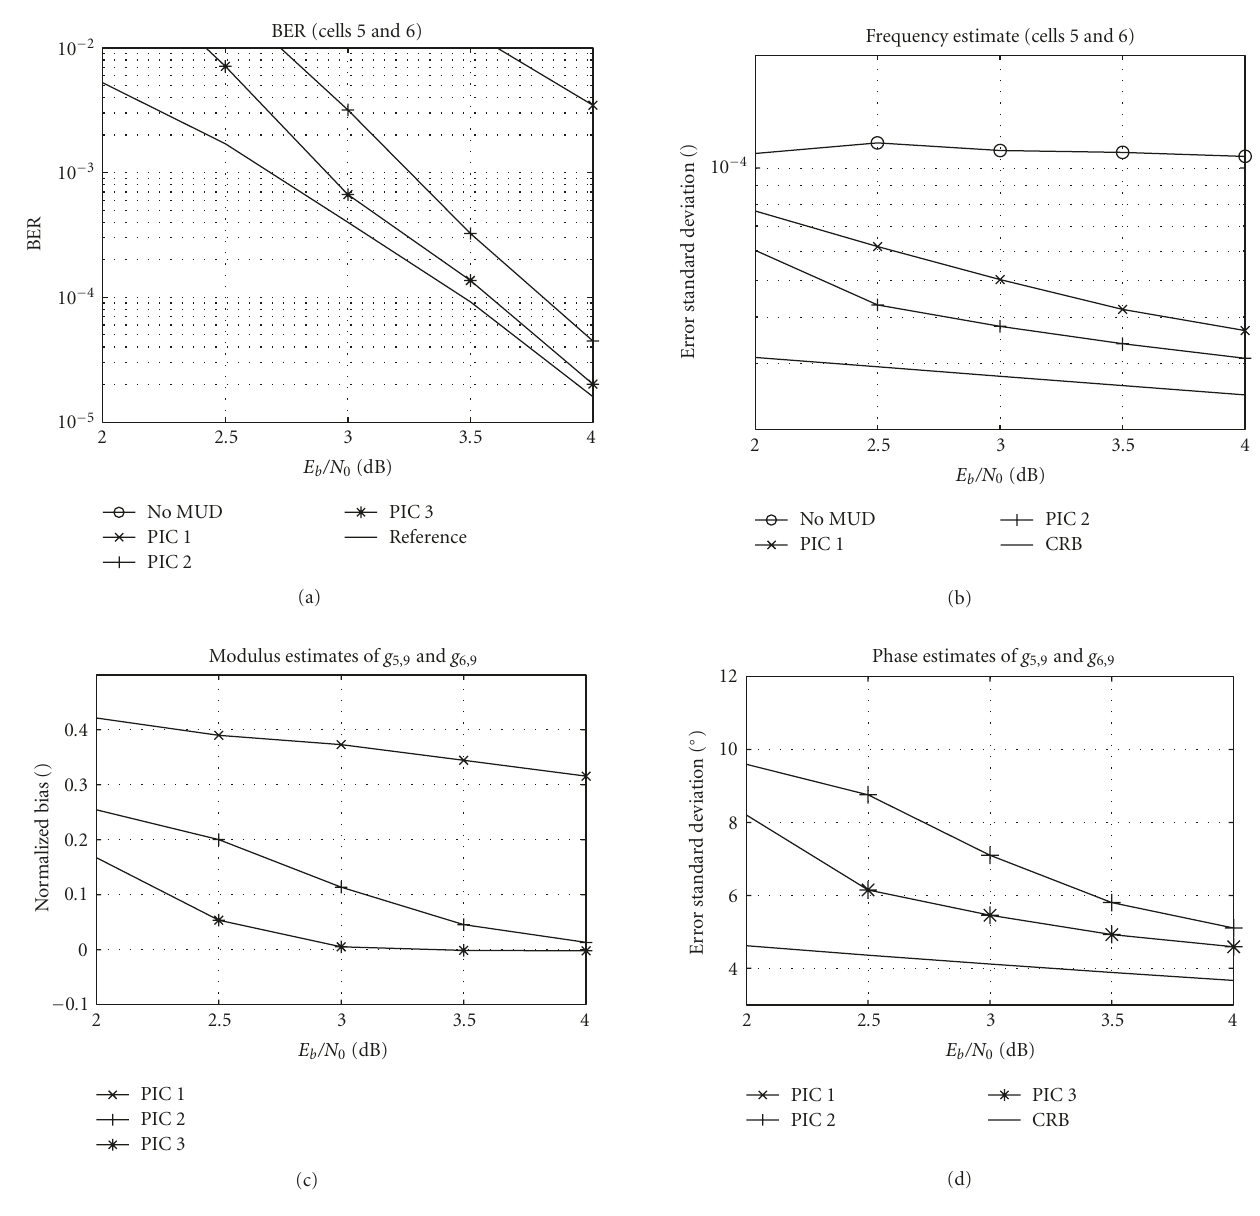
Figure 10: Results with frequency estimations: σ Δ fT = 2 · 10 − 4 , case